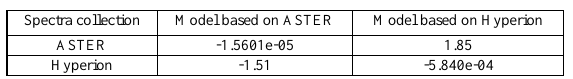
Table 5. Mean difference (MD) scaled with 100 in NIR (785– 900 nm) reflectance between OLI and transformed MSI using corresponding model presented in Table